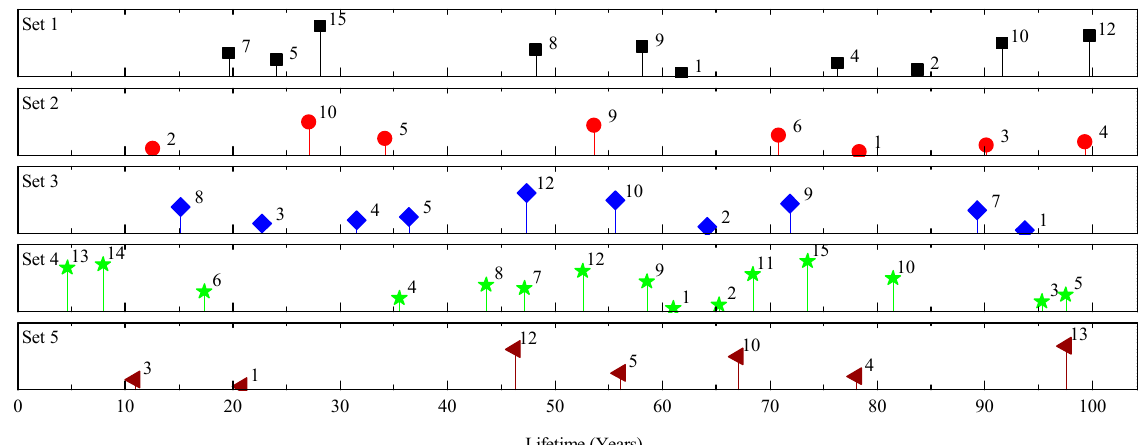
Figure 12. The sequence of the phase spectrum earthquakes used to generate compatible earthquakes in multi-hazard scenarios (the numbers are assigned according to Table 5). Table 5. List of the earthquake used for a phase spectrum to scale the probable earthquake events.